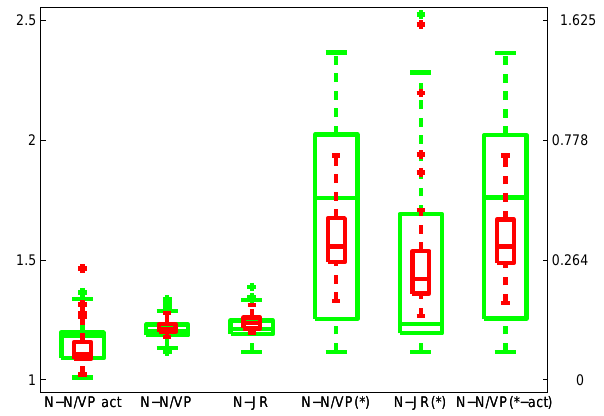
Fig. 3. Predicted growth factors as a function of predictive tech- nique and number of compounds used in the partitioning calcula- tions. The three bars on the left only allow water to equilibrate with the ambient humidity (and are the same as the first, second and fourth bars of Fig. 2), the three bars on the right with very much greater variability (denoted “*”) use the same techniques but as- sume re-equilibration of all semi-volatiles on drying within the HT- DMA (case “b” in Fig. 1). Note that (*-act) refers to the case where non-ideality was assumed to play a role on drying, i.e. for a non- aqueous aerosol at 0%RH. As in Fig. 2, 10000 compound simula- tions are shown as red boxes, 2 compound simulations as green and the predictive technique acronyms displayed on the x-axis are listed in Table 1. The left-hand y-axis lists calculated GF D , the right side lists the corresponding κ